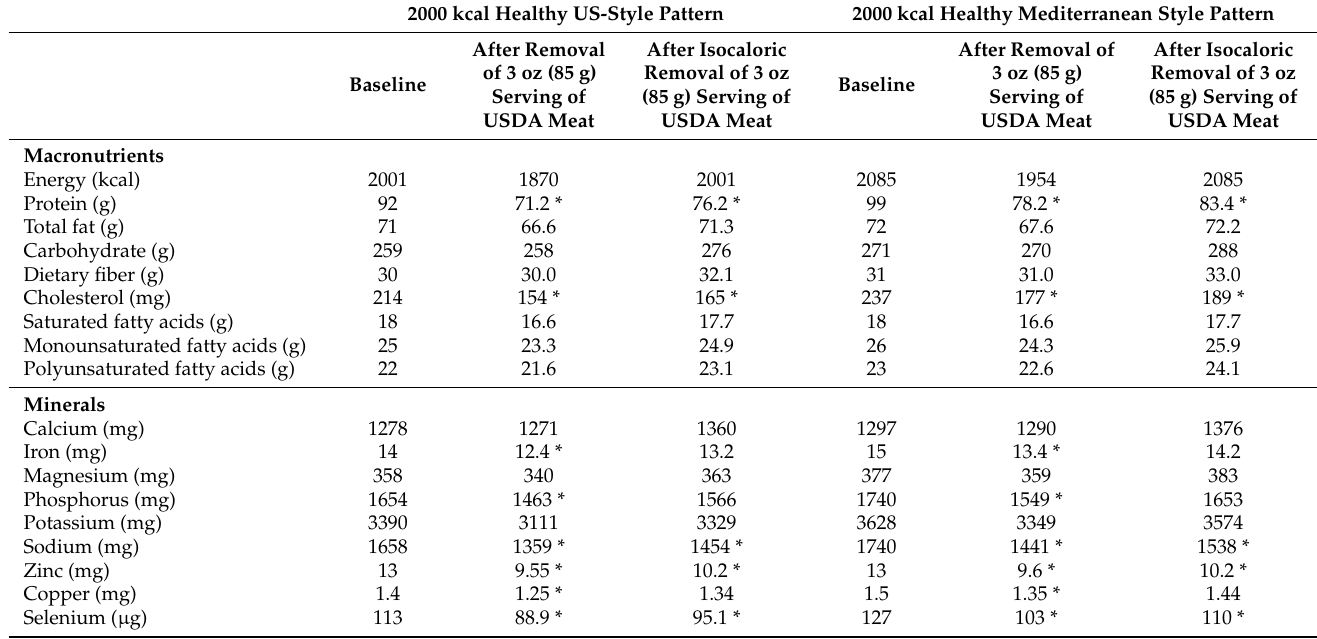
Table 3. Energy and nutrients in 2000 kcal Healthy Dietary Patterns before and after removal of a 3 oz (85 g) serving of USDA